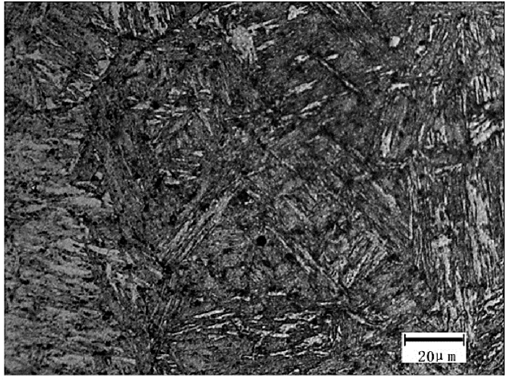
Figure 1. Microstructure of P110 steel.